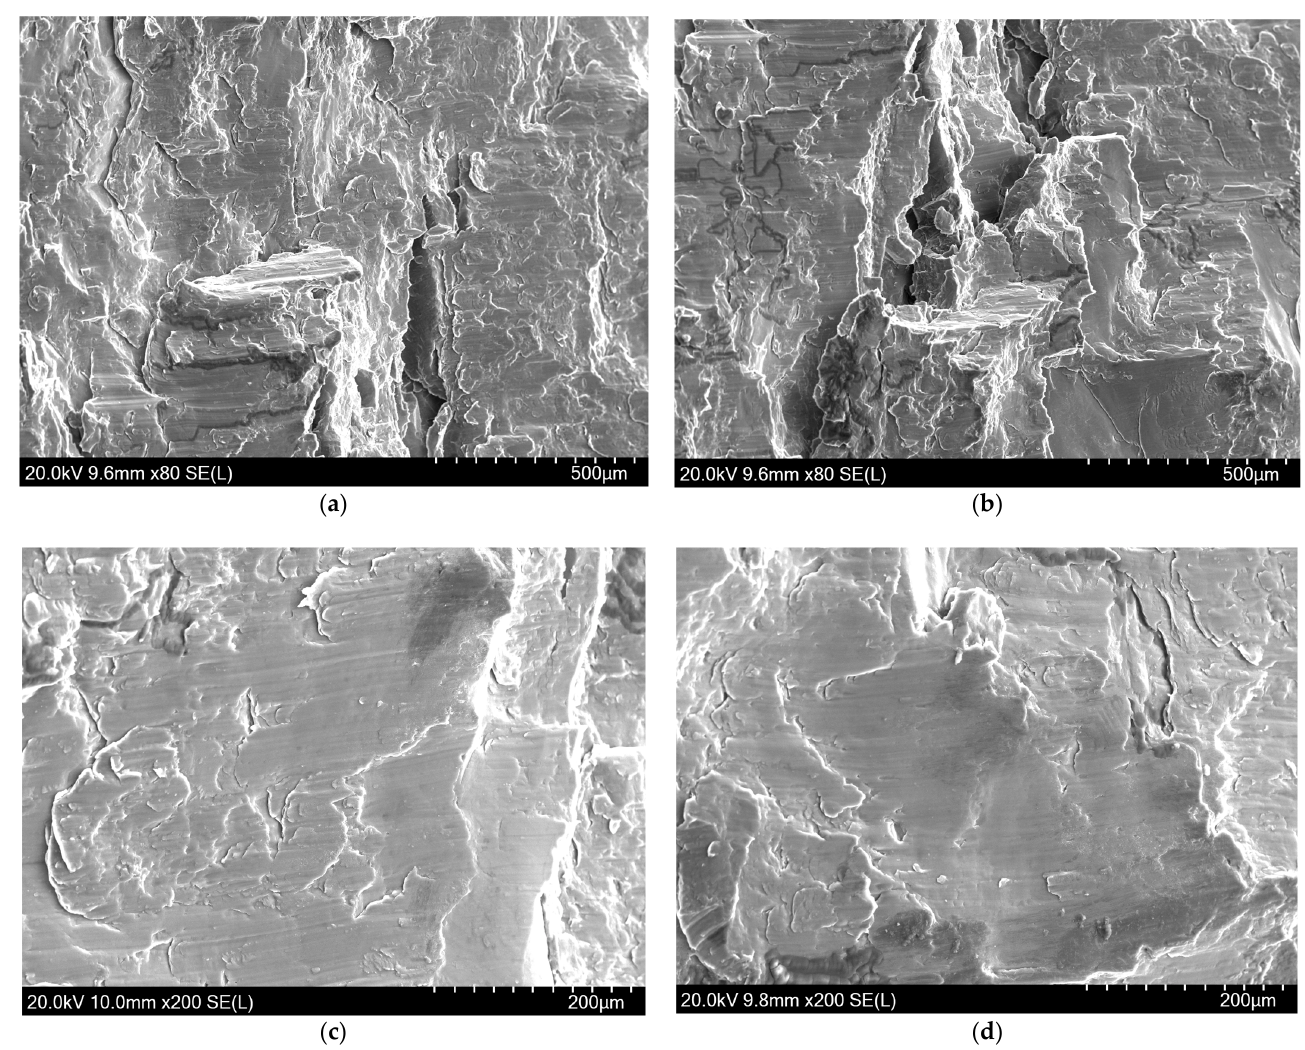
Figure 15. SEM images of Mg-Al-Ca-Mn alloy fractured in the ND direction show ( a,b ) the stepped and river patterns and ( c,d ) the smooth planes.